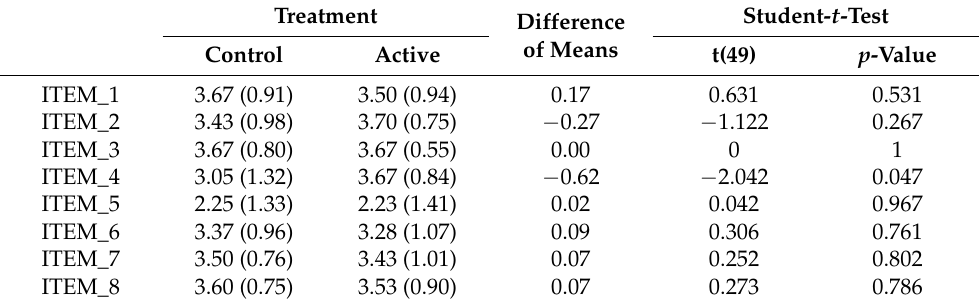
Figure 2. Evolution of xerostomia in the two study groups. Within one same group, the different lowercase letters (a–b) indicate statistically significant differences between the two timepoints (Bonferroni correction). At the same timepoint, different uppercase letters (A–B) indicate statistically significant differences between the two groups (Bonferroni correction). Table 2. Descriptive and comparative satisfaction questionnaire findings between treatments.